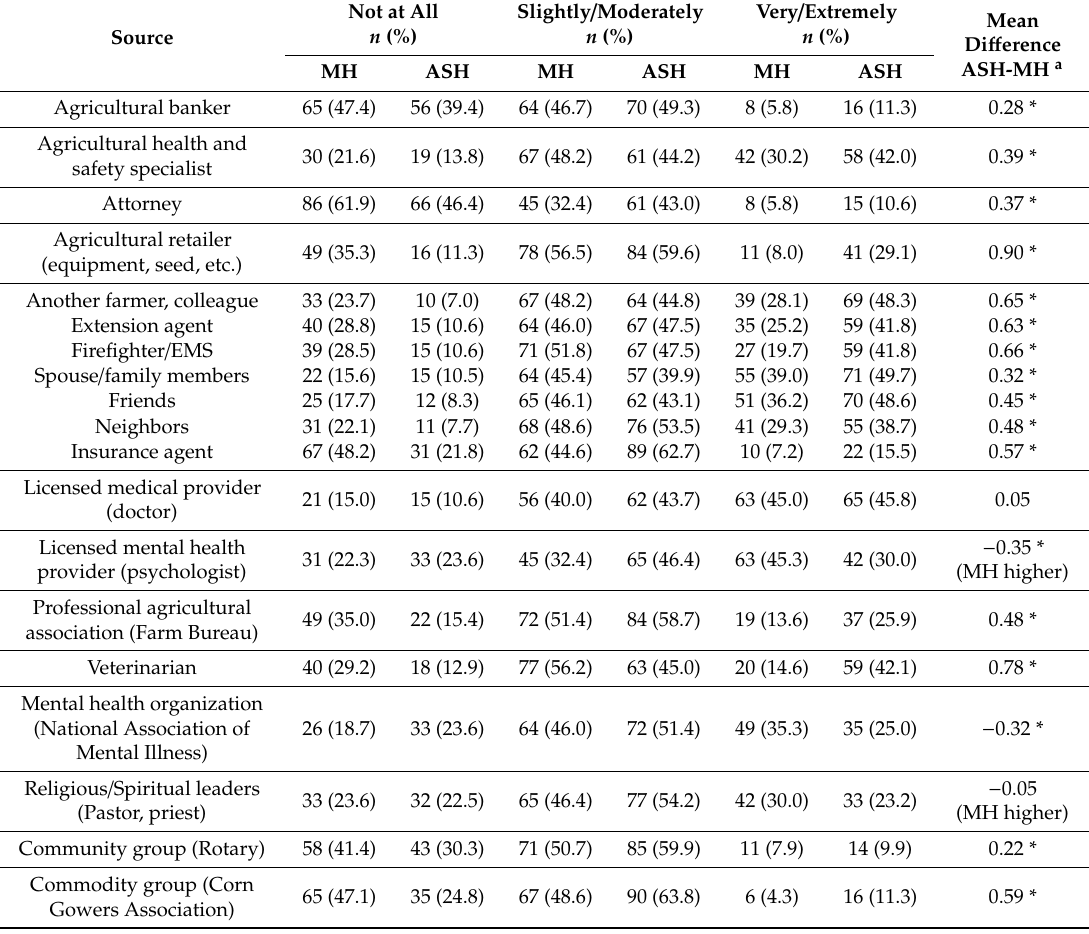
Table 2. Receptiveness of respondents to senders of mental health information (MH) and agricultural safety and health information (ASH) ( n =